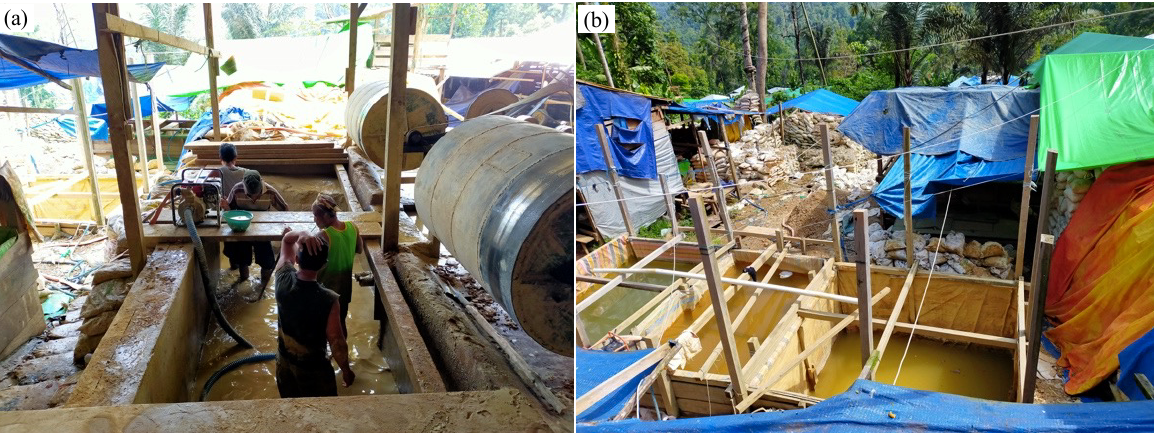
Figure 3. Pools of water mixed with hydrogen peroxide ( a ) and mercury mixed with cyanide ( b ) for immersing materials in the study sites